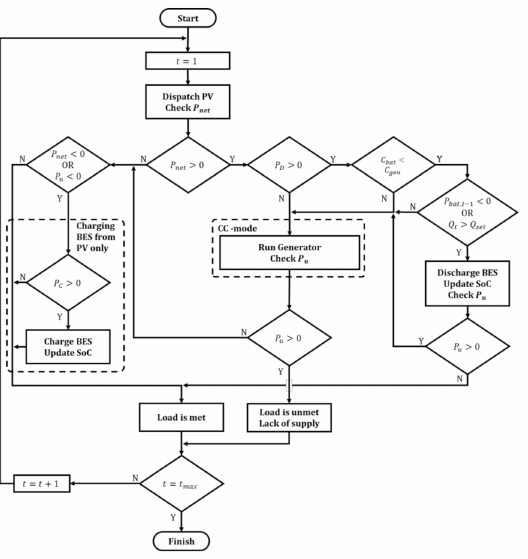
Figure 2. Cycle Charging (CC) control strategy. This strategy tends to store energy in the battery every time generator is operated. BES is only discharged when it reaches maximum SOC or has been discharged in the previous